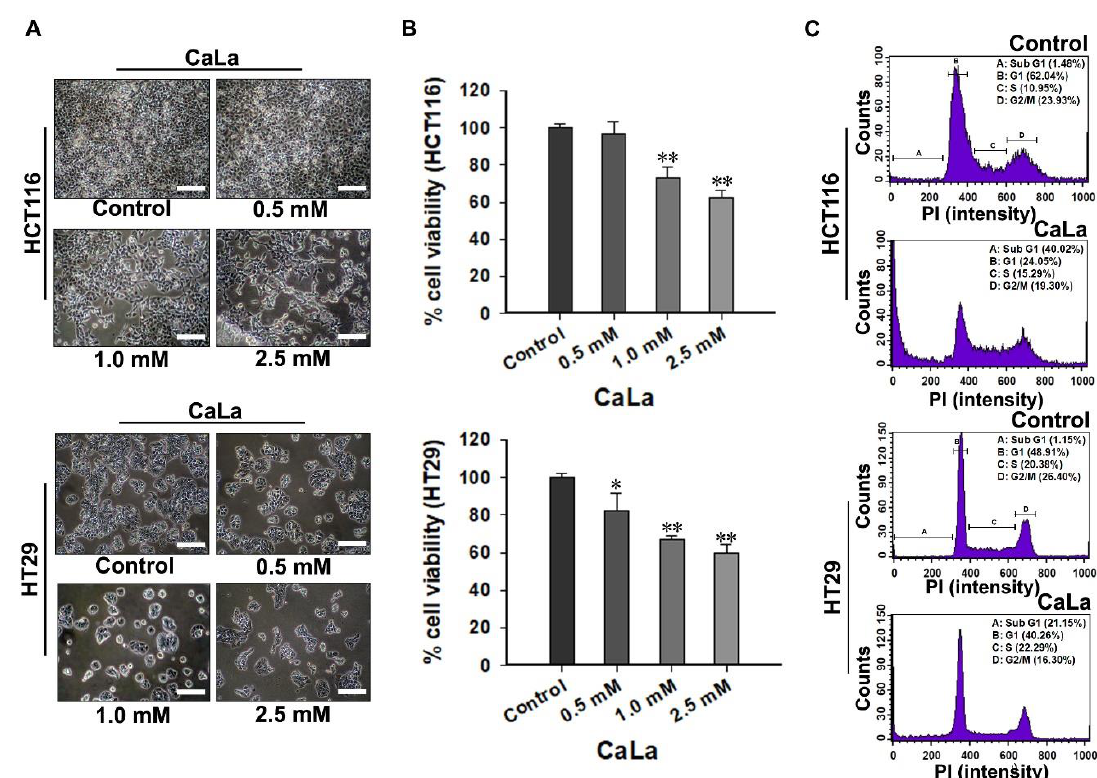
Figure 2. Antitumor effect of lactate calcium salt (CaLa) on colorectal cancer (CRC) cells to determine the appropriate concentration of CaLa in combination with sorafenib. ( A ) Morphological changes in CRC cells were observed using an optical microscope. Scale bars: 100 μm. Enlarged pictures are provided in Supplementary Figure S3. ( B ) Quantitative analysis of the cell viability following treatment of CRC cells with increased concentrations of CaLa. ( C ) Representative cell cycle profiles of the control and 2.5 mM CaLa-treated CRC cells. All results were validated based on quintuplicate analysis. * p < 0.05 and ** p < 0.001 vs. Control. Results are mean ± SD.